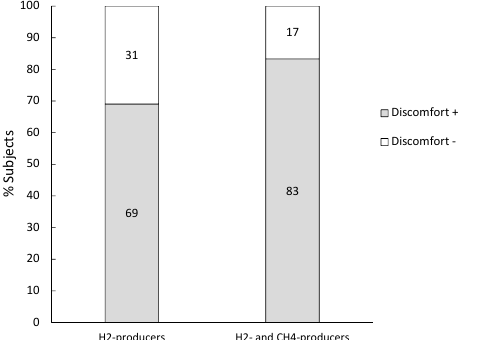
Figure 4. Percentage of subjects diagnosed with lactose malabsorption or SIBO that reported discomfort.